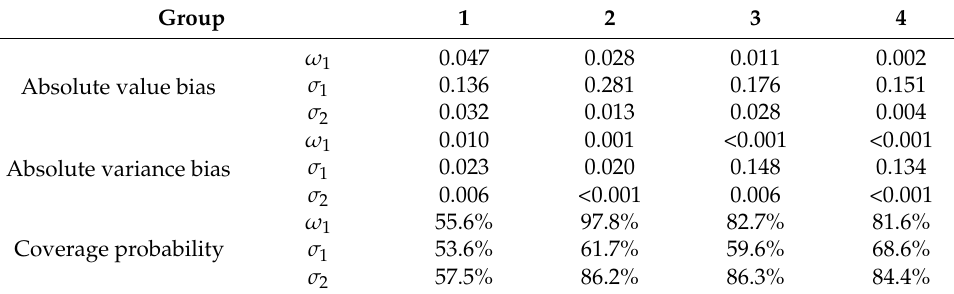
Table 4. False parametric model results.